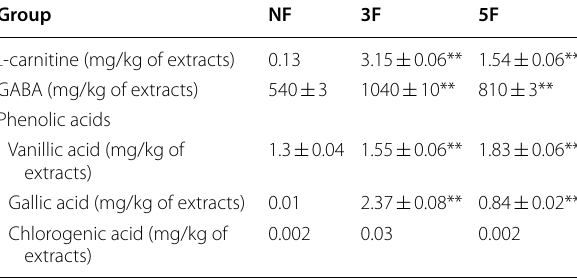
Table 1 l -carnitine, GABA and phenolic acids in